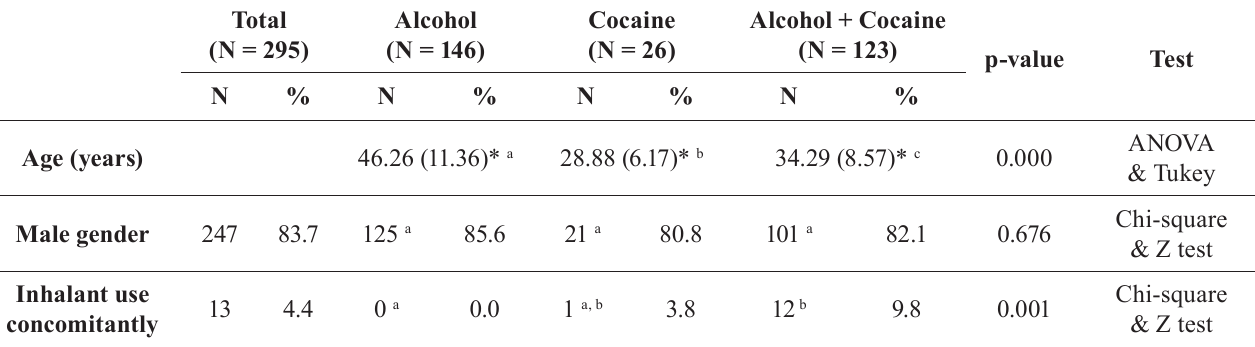
TABLE I - M ain drugs of use, concomitant use of drugs, age and gender of patients attended at CAPS-AD of Betim